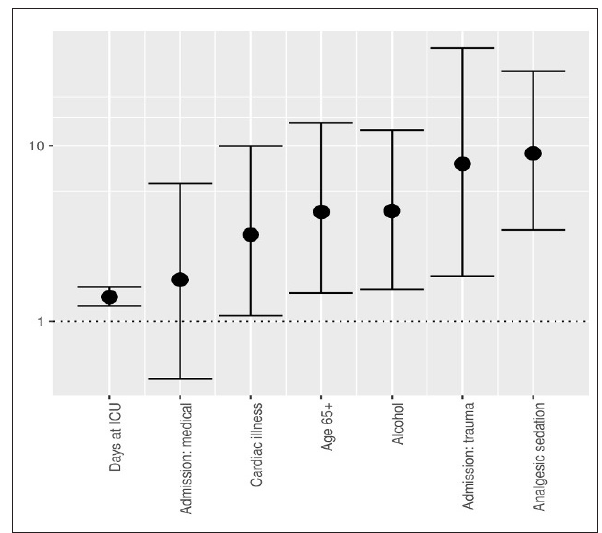
Fig. 3. Odds ratio confidence intervals of the independent vari- ables of the logistic regression modelling CAM+/CAM- (loga- rithmic scale).